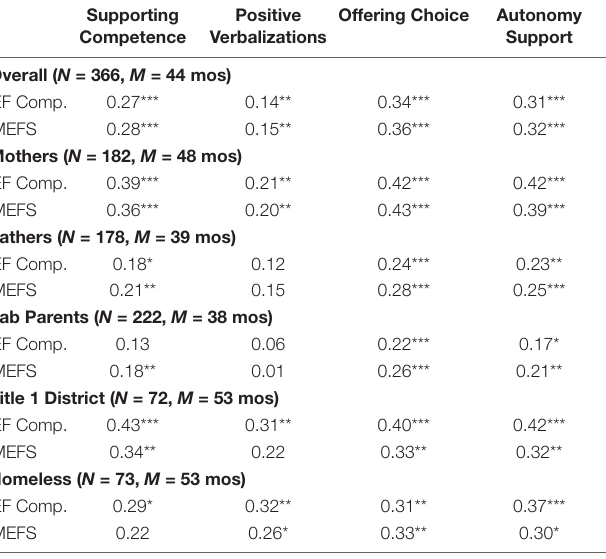
TABLE 2 | Correlations between autonomy support and child EF in multiple